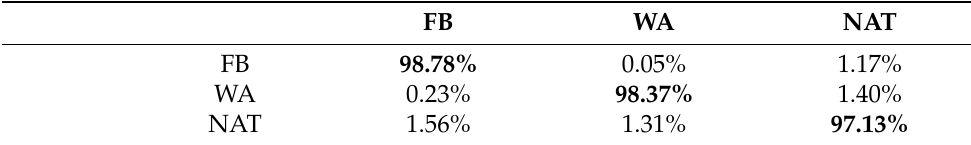
Table 1. Confusion matrix of the baseline single-task model on patches extracted from images. FBH and FBL represent high-quality and low-quality patches from Facebook. WA and NAT represent WhatsApp and native image patches respectively.